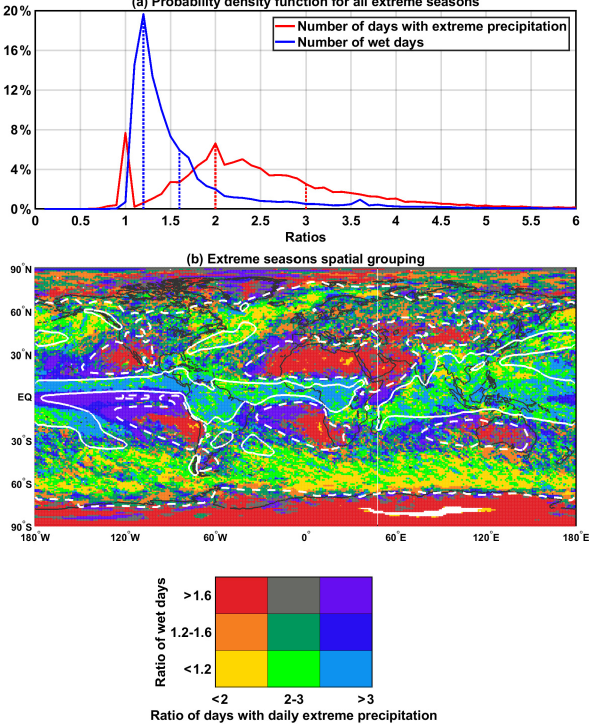
Figure 5. (a) Probability density function of the number of ratios of daily precipitation extremes and wet days for all extreme seasons and for all grid points (ratios with respect to the seasonal average). Vertical dotted lines correspond to ratios of 1.2, 1.6, 2 and 3. (b) At- tribution of grid points to nine categories of pairs of ratios of the number of wet days and of daily precipitation extremes. Dashed and solid white contours depict annual average precipitation of 500 and 1500mm, respectively. Dotted lines in (a) show the category bound- aries used in (b)